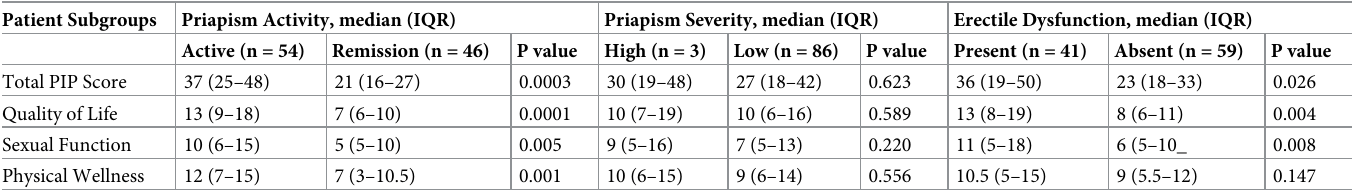
Table 2. A Priapism Impact Profile (PIP) questionnaire criterion-oriented validity of domains based on comparison of patient subgroups. Patient Subgroups Priapism Activity, median (IQR)